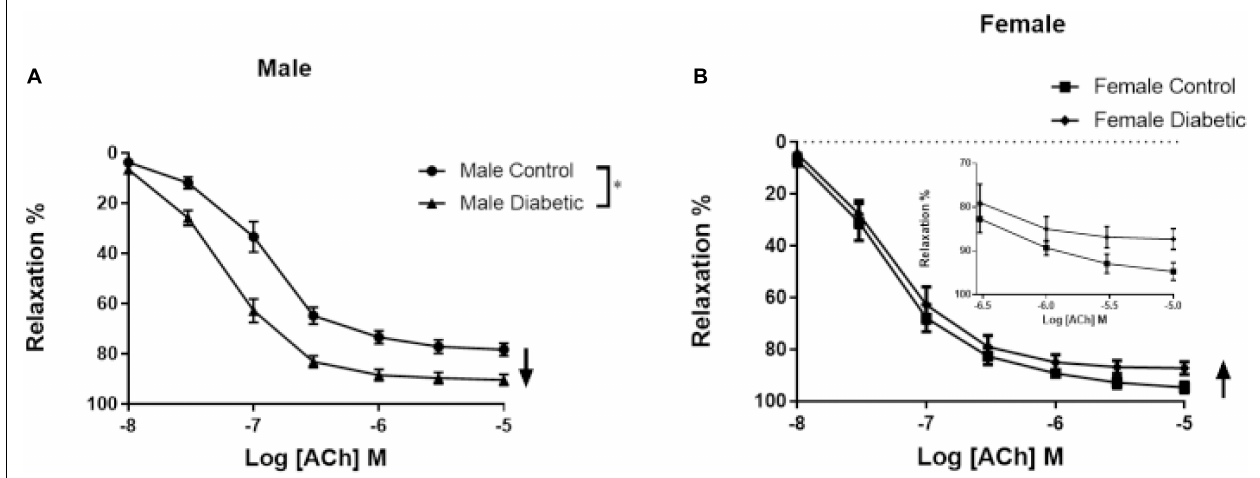
FIGURE 2 | Concentration-response curves to acetylcholine (ACh) in control and UCD-T2DM rat aorta. Relaxation responses to cumulative concentrations of ACh (10 − 8 to 10 − 5 M) in intact aortic rings pre-contracted with phenylephrine (PE, 2 µ M) from male (A) and female (B) control and diabetic rats. Data are expressed as mean ± SEM. n = 6–12 animals per group. * p < 0.05 between two groups analyzed using two-way ANOVA followed by Bonferroni’s post hoc test.